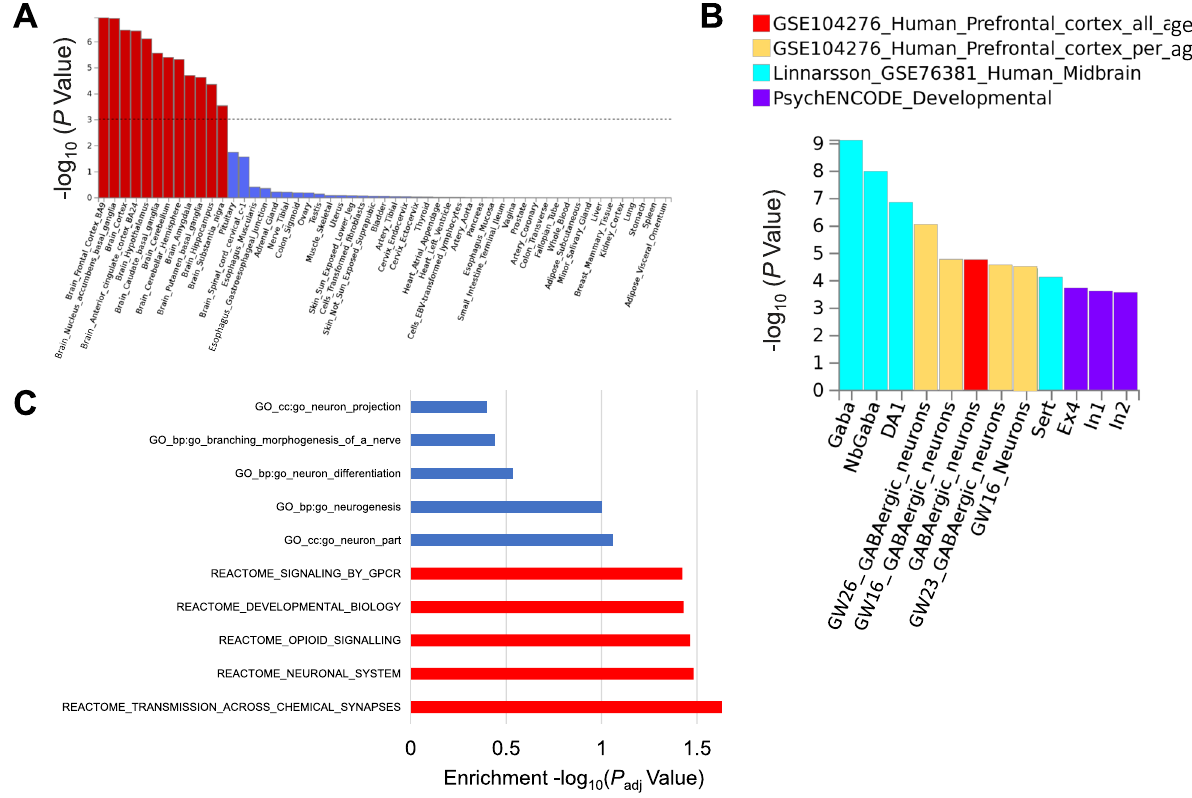
Fig. 3 Tissue expression, single-cell, and pathway-based enrichment analyses for daytime napping. A MAGMA tissue expression analysis using gene expression per tissue based on GTEx RNA-seq data for 53 speci fi c tissue types. Signi fi cant tissues ( P < 9.43 × 10 − 4 ) are shown in red. B Signi fi cant single- cell types from single-cell enrichment analyses using human brain datasets in FUMA. C Top pathways determined from analysis using MAGMA gene sets and Pascal (gene-set enrichment analysis using 1077 pathways from KEGG, REACTOME, BIOCARTA). Signi fi cant pathways are shown in red ( P adj < 0.05). All pathway and tissue expression analyses in this fi gure can be found in tabular form in Supplementary Table 10, Supplementary Data 8,